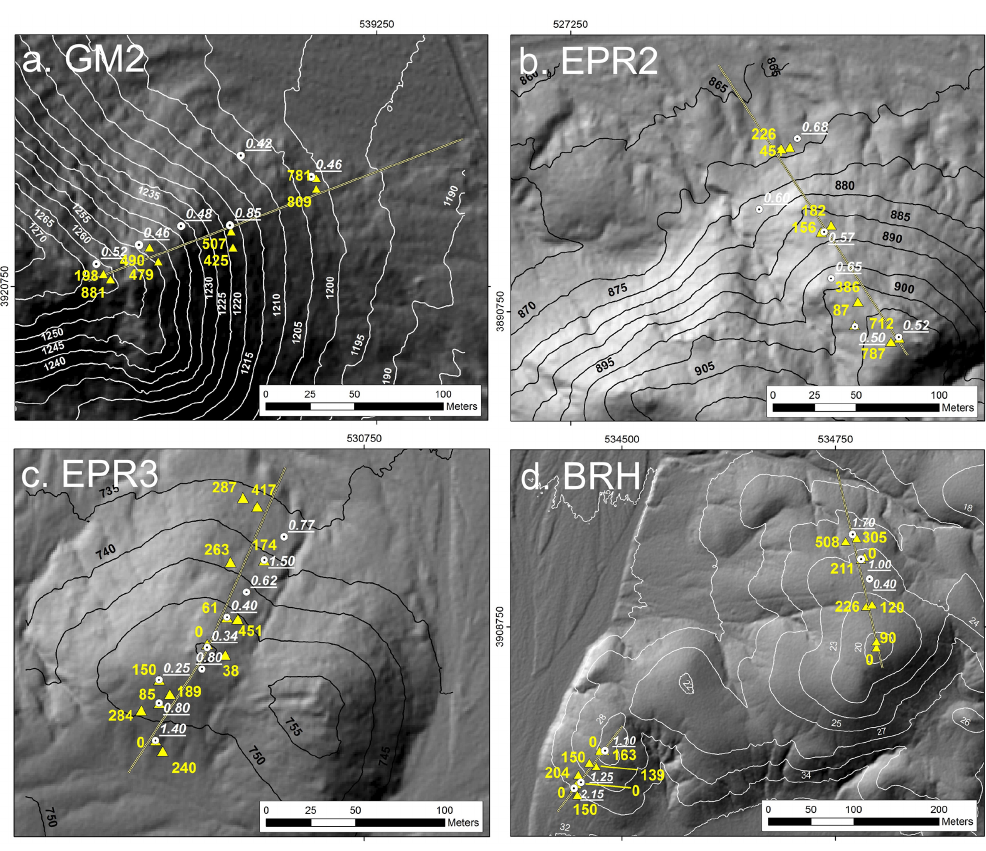
Figure 2. The spatial distribution of total 137 Cs inventories (Bqm − 2 ) per soil profile for each study site (yellow triangles and numbers): (a) GM2, (b) EPR2, (c) EPR3, (d) BRH north aspect, (e) BRH southwest aspect. Topographic transects are in yellow lines. Location and thickness (m) of studied soil pits (dug to bedrock) are represented by white circles and numbers. Topography from the lidar data is presented as contours and as shaded relief